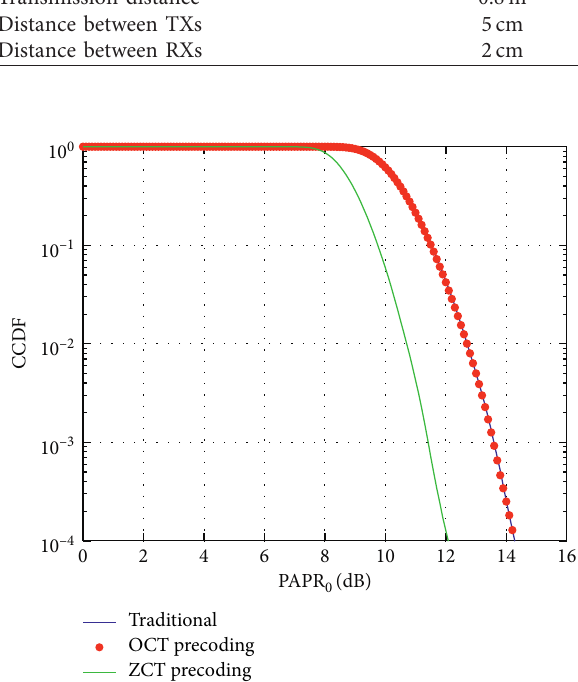
Figure 3: CCDF of PAPRs for different MIMO-OFDM VLC